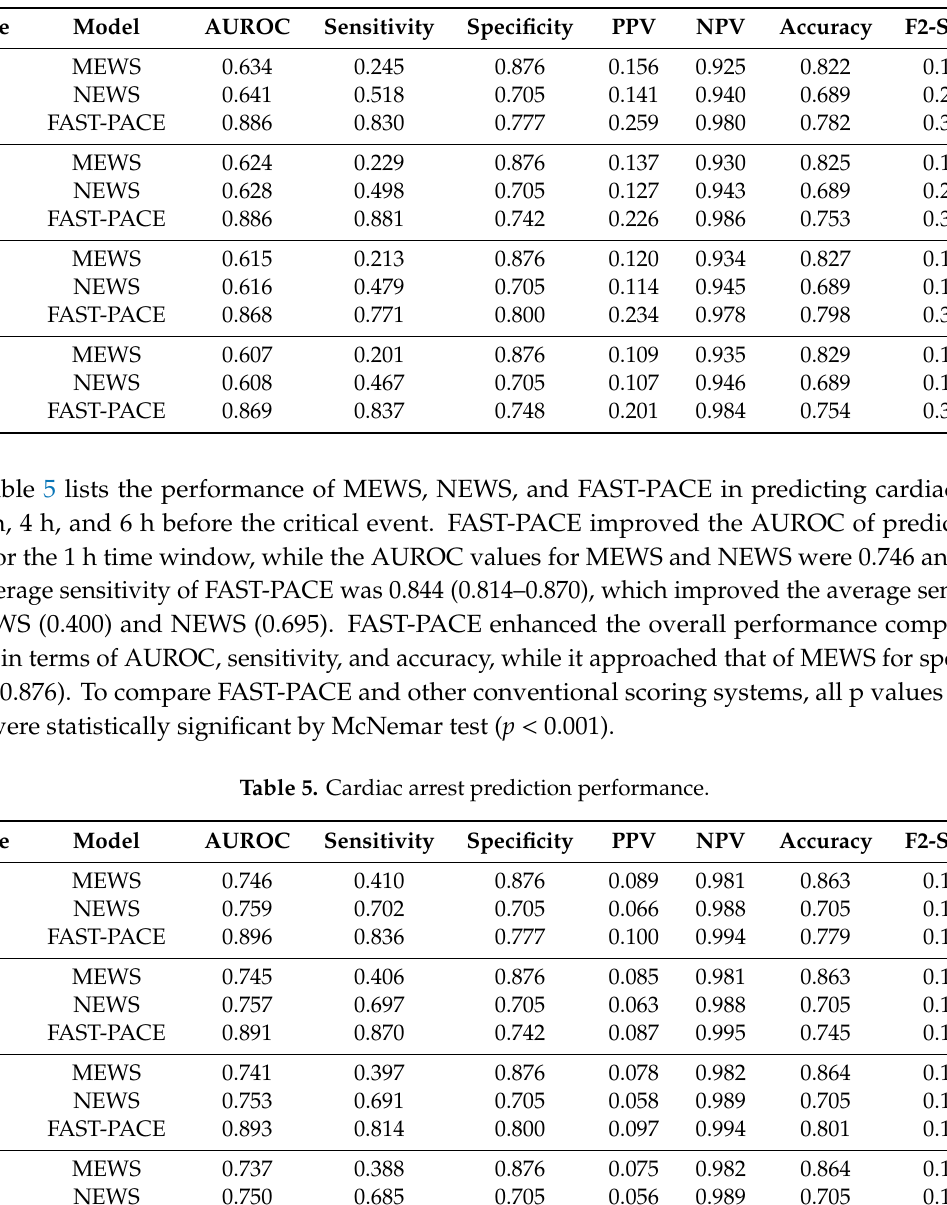
Table 4. Acute respiratory failure prediction performance. AUROC = area under the receiver operating characteristic curve; PPV = positive predictive value; NPV = negative predictive value.